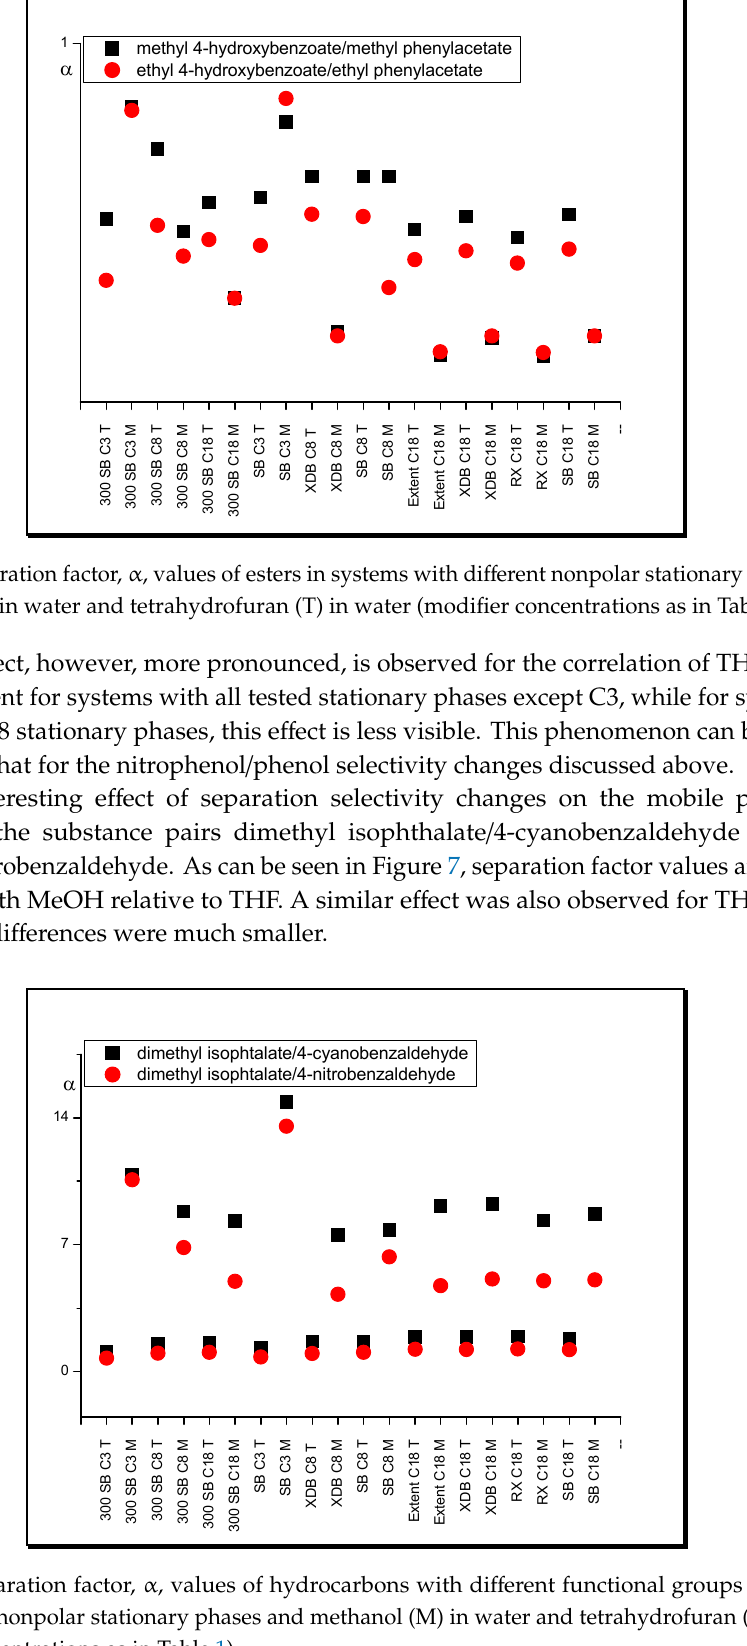
Figure 7. Separation factor, α , values of hydrocarbons with different functional groups in systems with different nonpolar stationary phases and methanol (M) in water and tetrahydrofuran (T) in water (modifier concentrations as in Table 1).